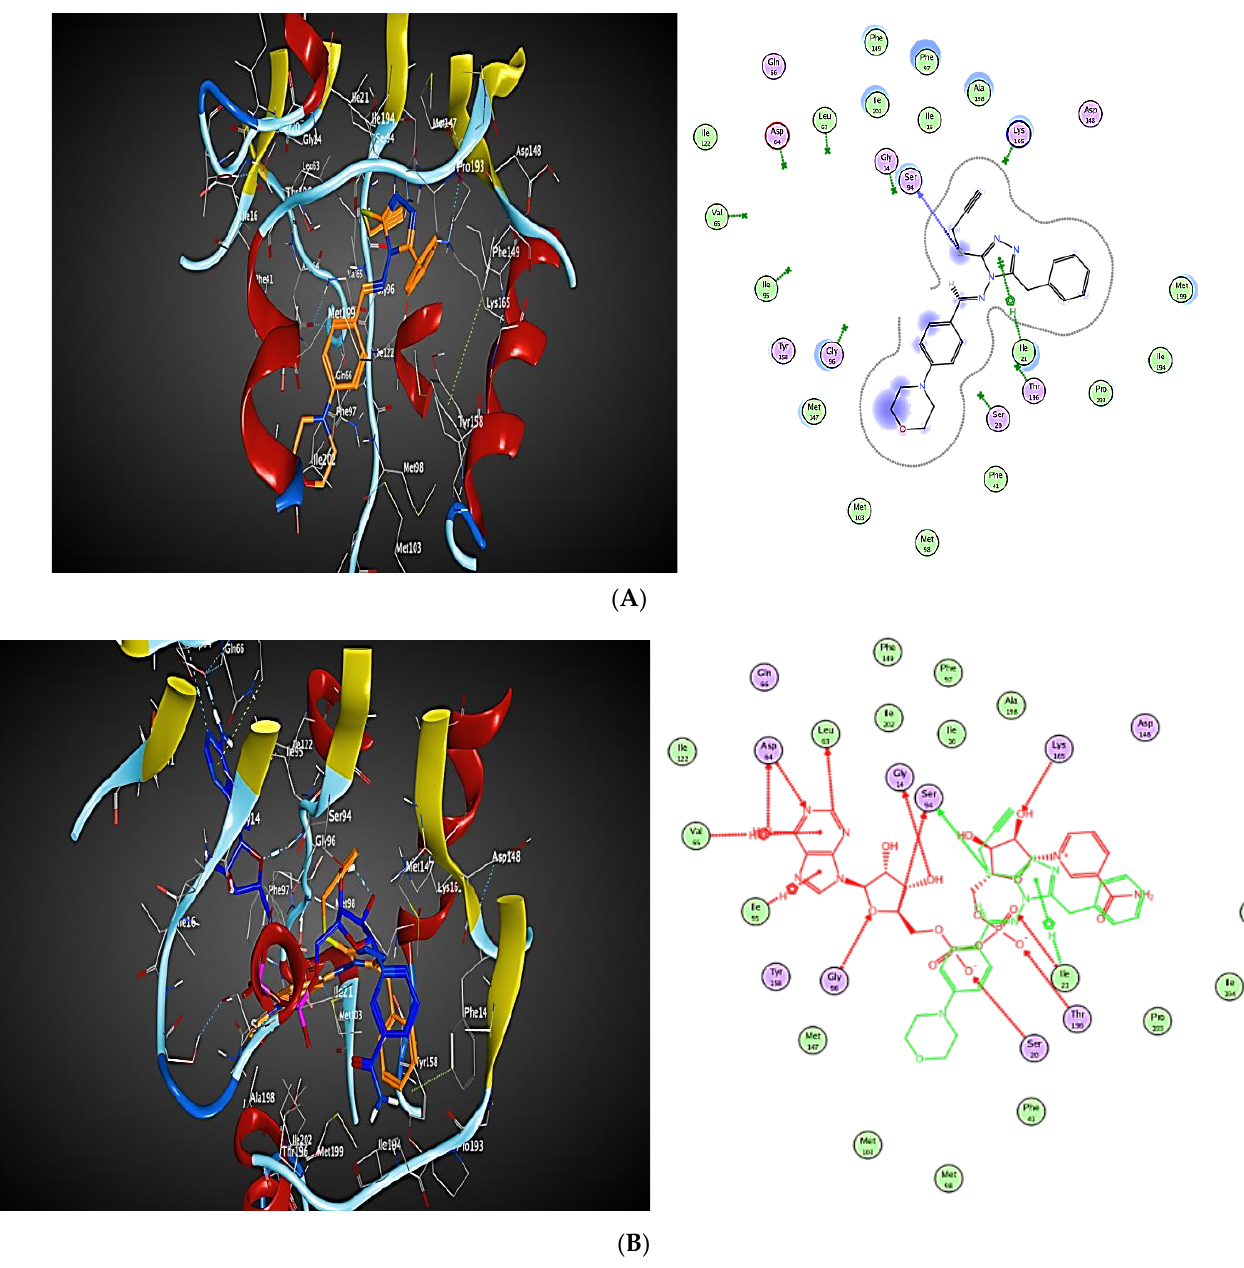
Figure 9. ( A ): Docking and binding pattern of compound 5c into inhA active site (PDB ID: 4TRO) in 2D (right panel) and 3D (left panel). ( B ): An overlay of the docked pose of compound 5c (brown) with the co-crystallized ligand (purple) into inhA active site in 2D (right panel) and 3D (left panel). The reported Inha- Inhibitors Lead structure B IC50 = 0.057 μM was selected to docked into 4TRO active site (Figure 10).